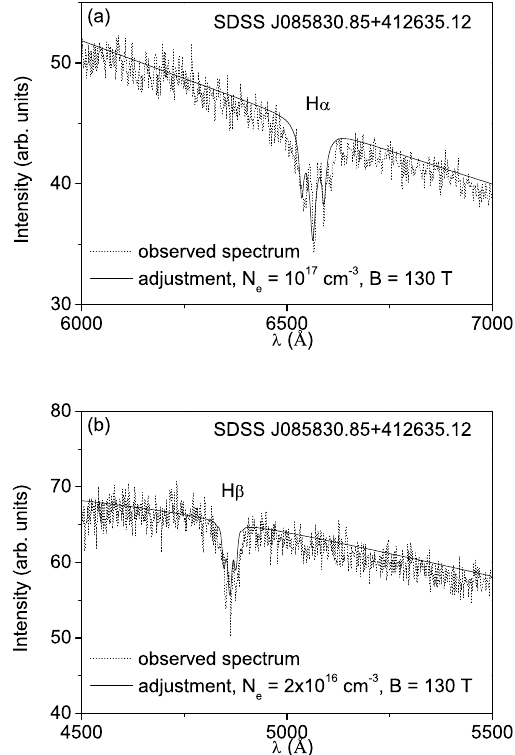
Figure 4. An analysis of the shape of absorption lines provides information on the plasma parameters. Here, an adjustment of (a) H α and (b) H β using the Stark-Zeeman line shape model is presented. These lines have been analyzed independently assuming a homogeneous slab geometry. The obtained values for N e and B provide a first order-of-magnitude